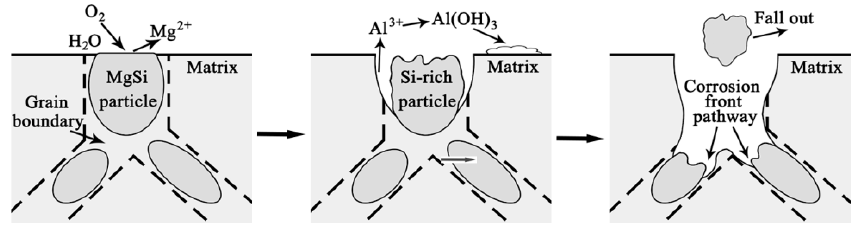
Figure 9. Schematic diagram of the corrosion evolution of a cross-section of the Al-Mg-Si alloy.